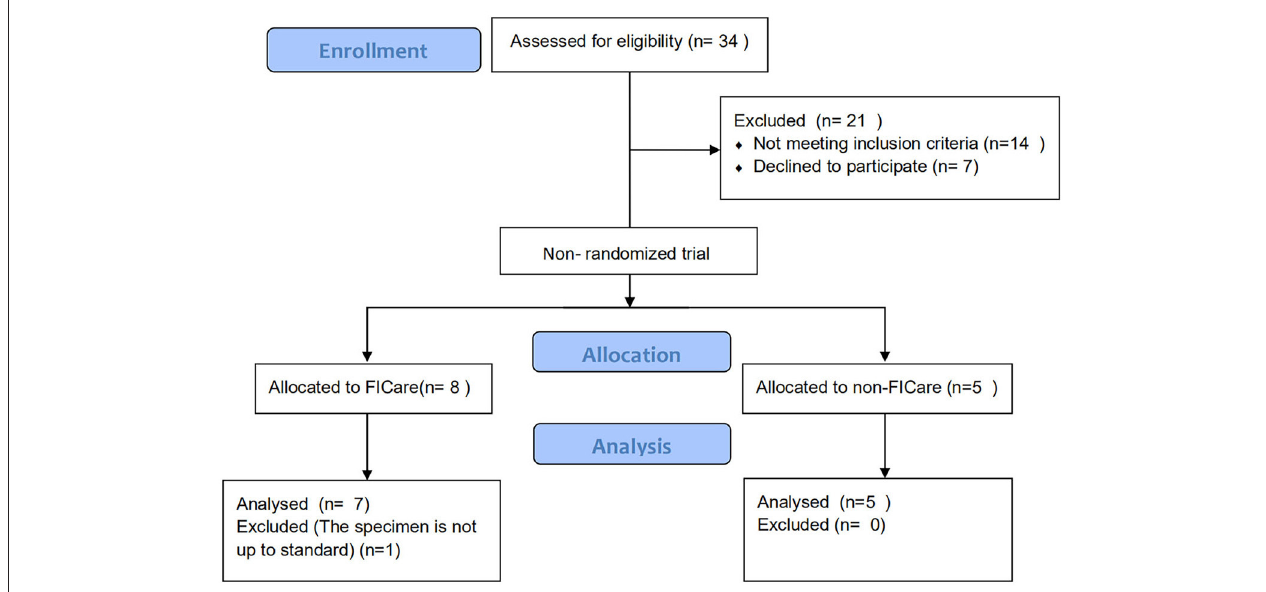
FIGURE 1 | Flowchart of patient